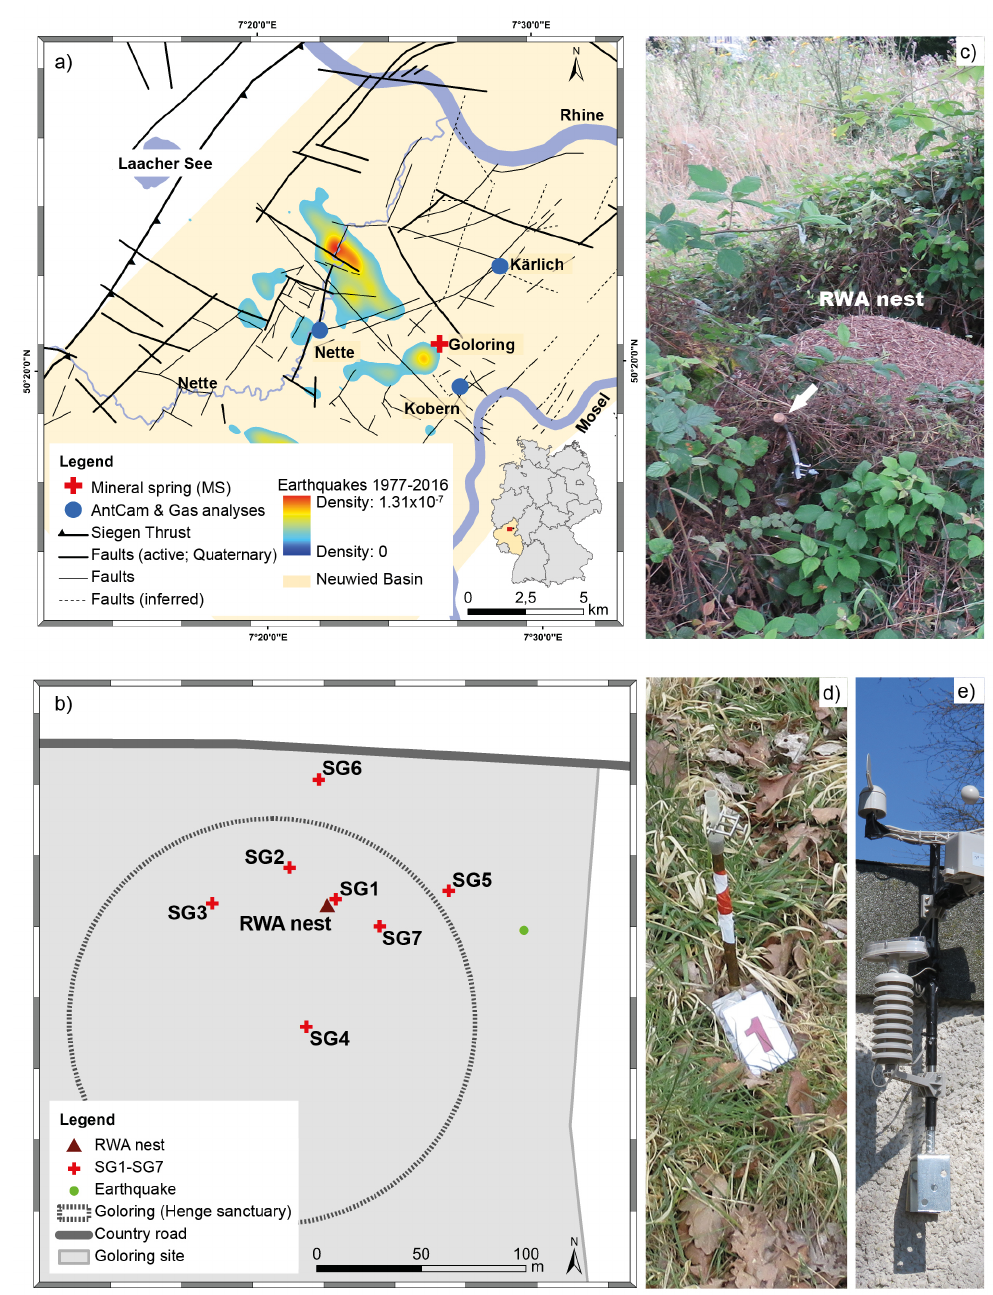
Figure 2. Location of the Goloring study site (red cross) ≈ 15 km SE of the Laacher See volcano within the Neuwied Basin (light yellow area). The map ( a ) shows tectonic structures (black lines) and probability density of the earthquake events from 1977–2016 related to the Ochtendunger Fault Zone (OFZ; rainbow contours showing the hot spots (red color) of earthquake events within the OFZ rarely exceeding local magnitude of 4.0; modified after [28]). The inset shows the location of the study site within Germany. CO 2 , He, and Rn were sampled at the Goloring site with its Iron-aged henge sanctuary from a RWA nest, soil, and the ambient air; no fault zones had been reported and identified previously from the Goloring study site ( b ). Photographs show ( c ) the permanent nest gas probe (white arrow) and the RWA nest, ( d ) example of a permanent soil gas (SG1) probe with marked flag, and ( e ) the meteorological station (all photographs: G. M.